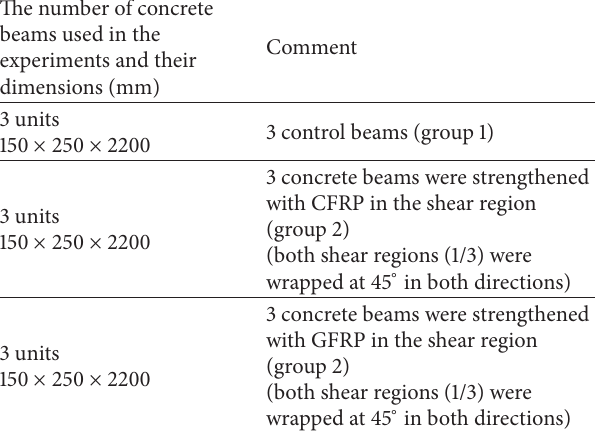
Table 1: Strengthening plan